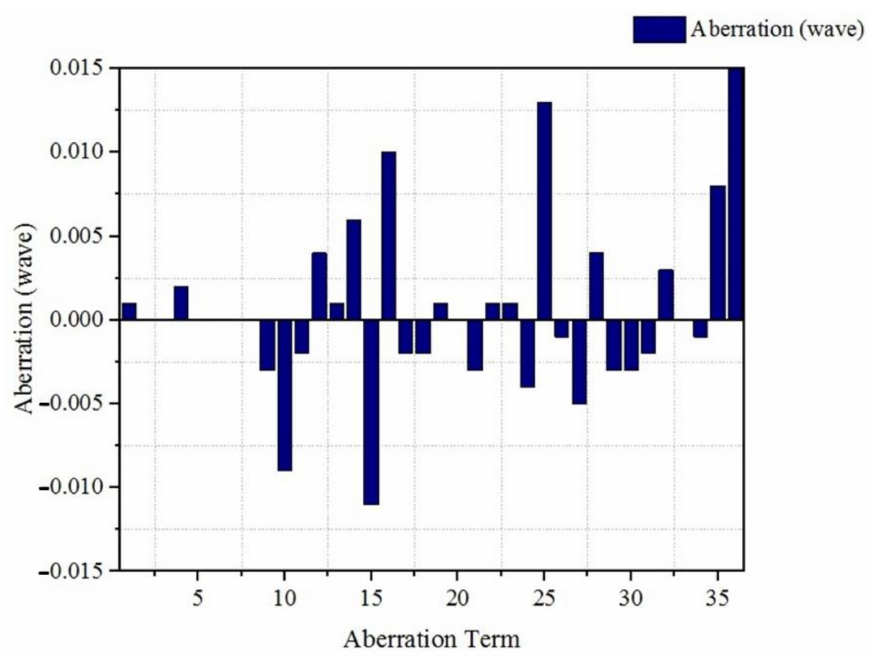
Figure 12. Zernike coefficient.